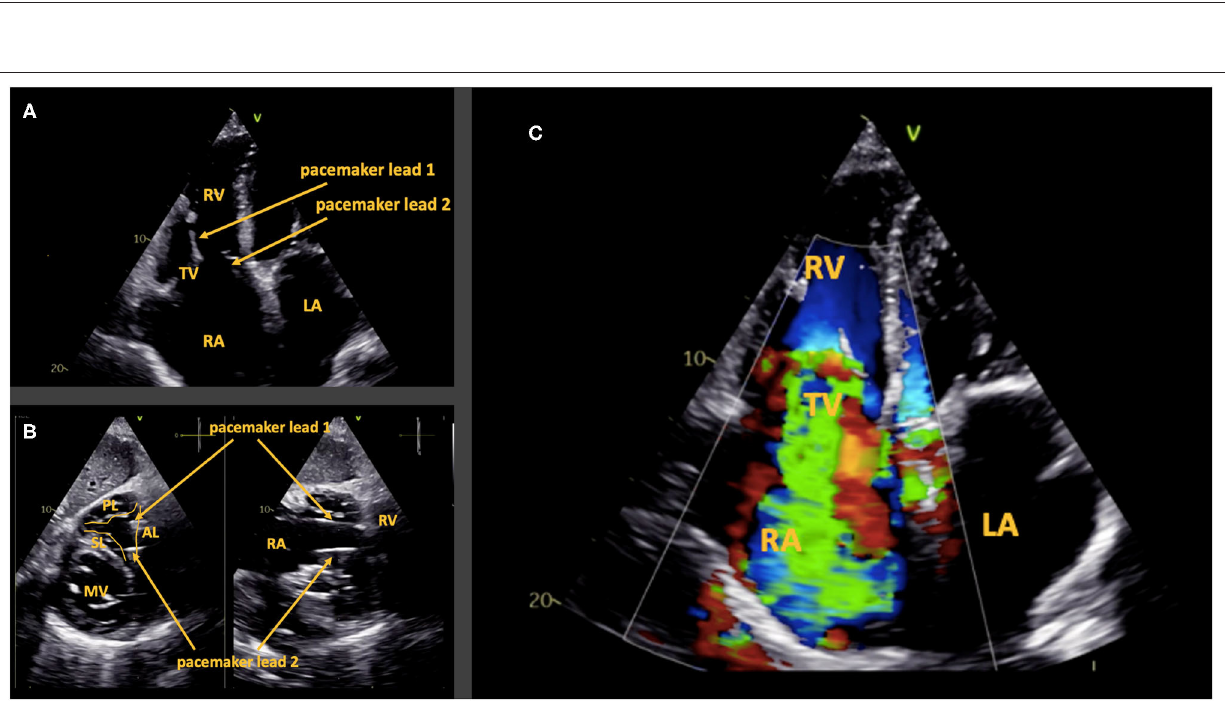
FIGURE 4 | Case 3: Anterior leaflet impingement by a pacemaker lead. Two trans-tricuspid pacemaker leads are present (A) . The transthoracic subcostal en face view of the tricuspid valve shows one lead in the antero-posterior commissure and the other in the antero-septal commissure (B) . Leaflet impingement of the anterior leaflet causes “torrential” tricuspid regurgitation (C) . AL, anterior leaflet; PL, posterior leaflet; SL, septal leaflet; RA, right atrium; RV, right ventricle; LA, left atrium; TV, tricuspid valve; MV, mitral